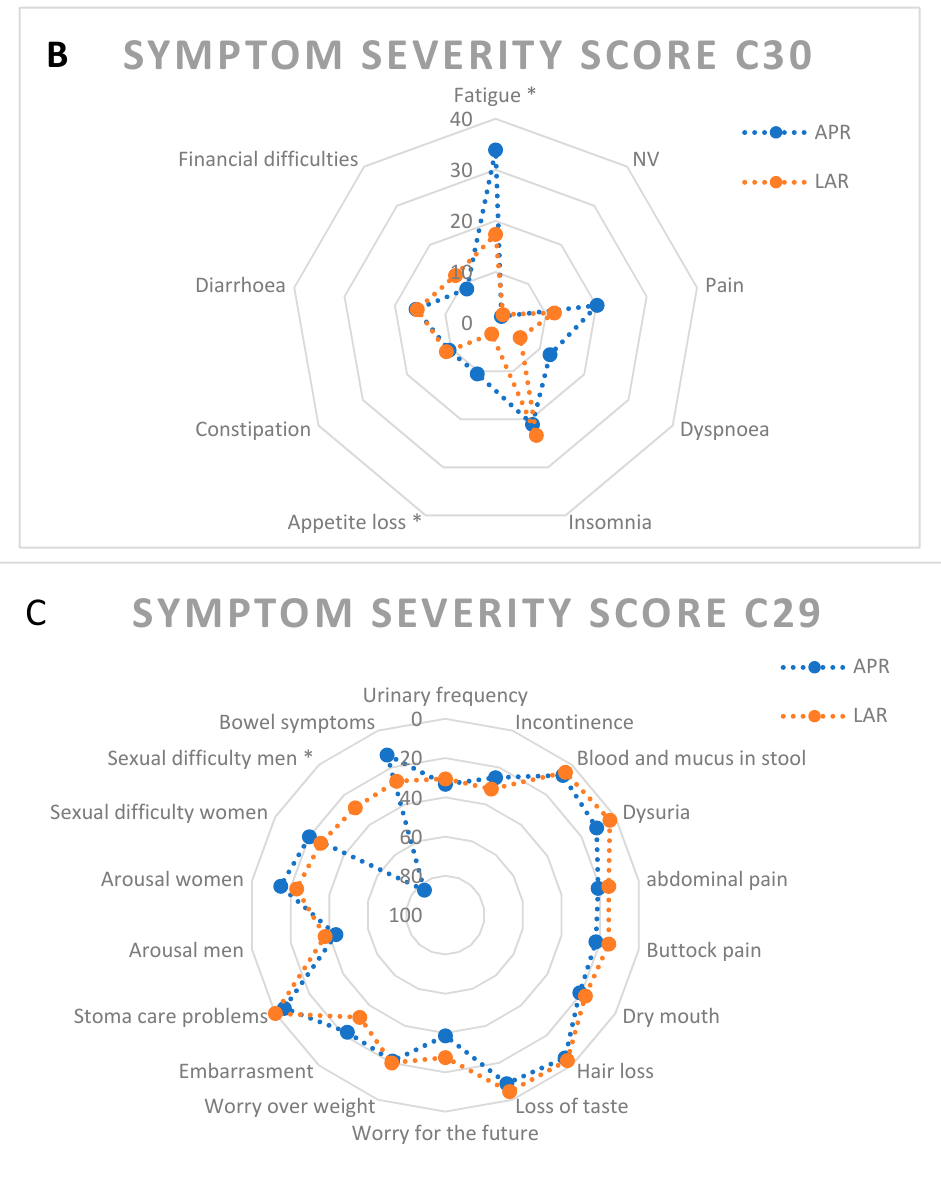
Figure 3. Radar charts depicting quality of life per operation type. Means are given. * signifies statistical significance at p < 0.05. ( A ) Functional scores and QoL item. ( B ) QLQ-C30 symptom scores. ( C ) QLQ-CR29 symptom scores.